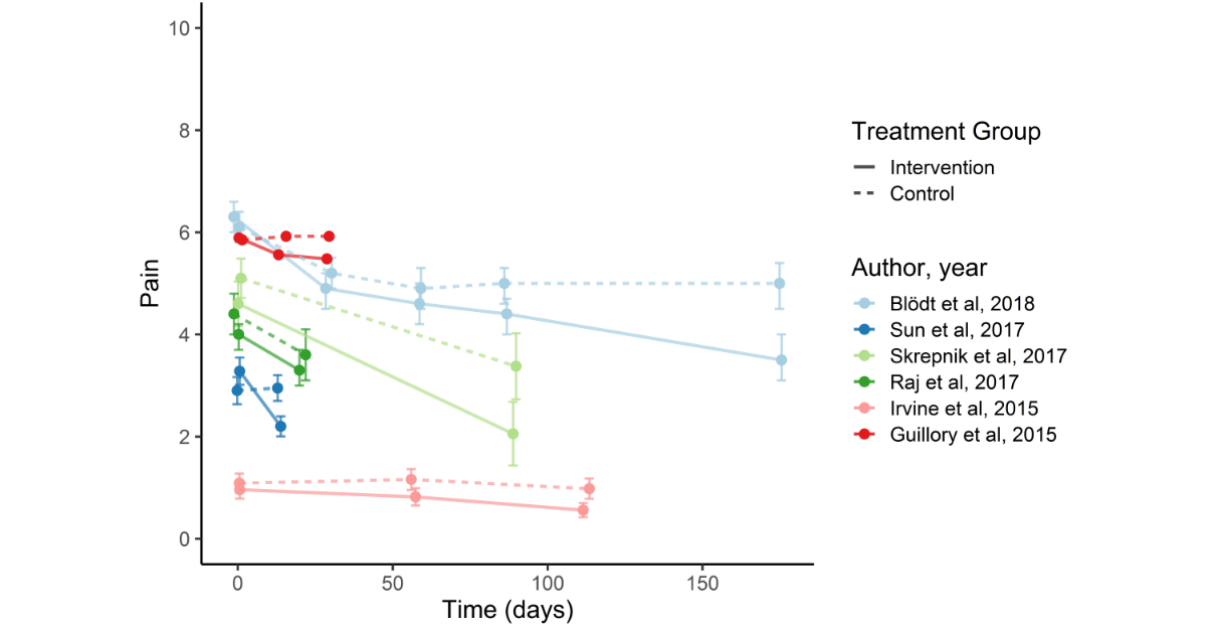
Figure 2. Improvement in pain over time in multiple armed studies. Pain scale (Numeric Rating Scale): 0-10.